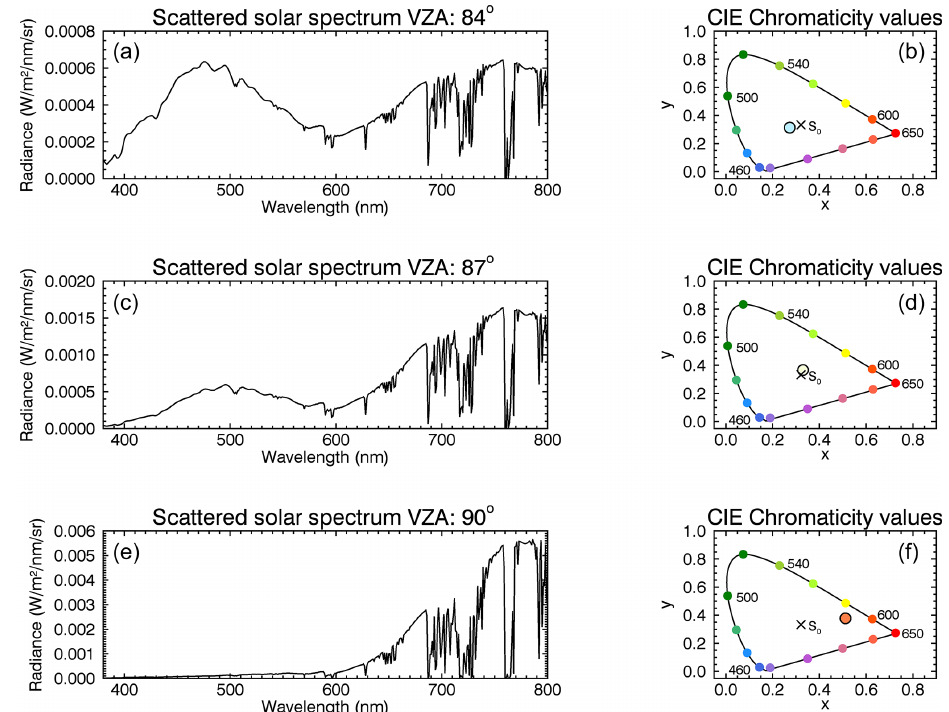
Figure 10. Solar scattering spectra (a, c, e) and CIE chromaticity diagrams (b, d, f) for an observer on the Earth’s surface and for SZA = 98 ◦ ; VZA = 84, 87, and 90 ◦ (from top to bottom); and SAA = 0 ◦ . The simulations are calculated for NLCs with the following parameters: